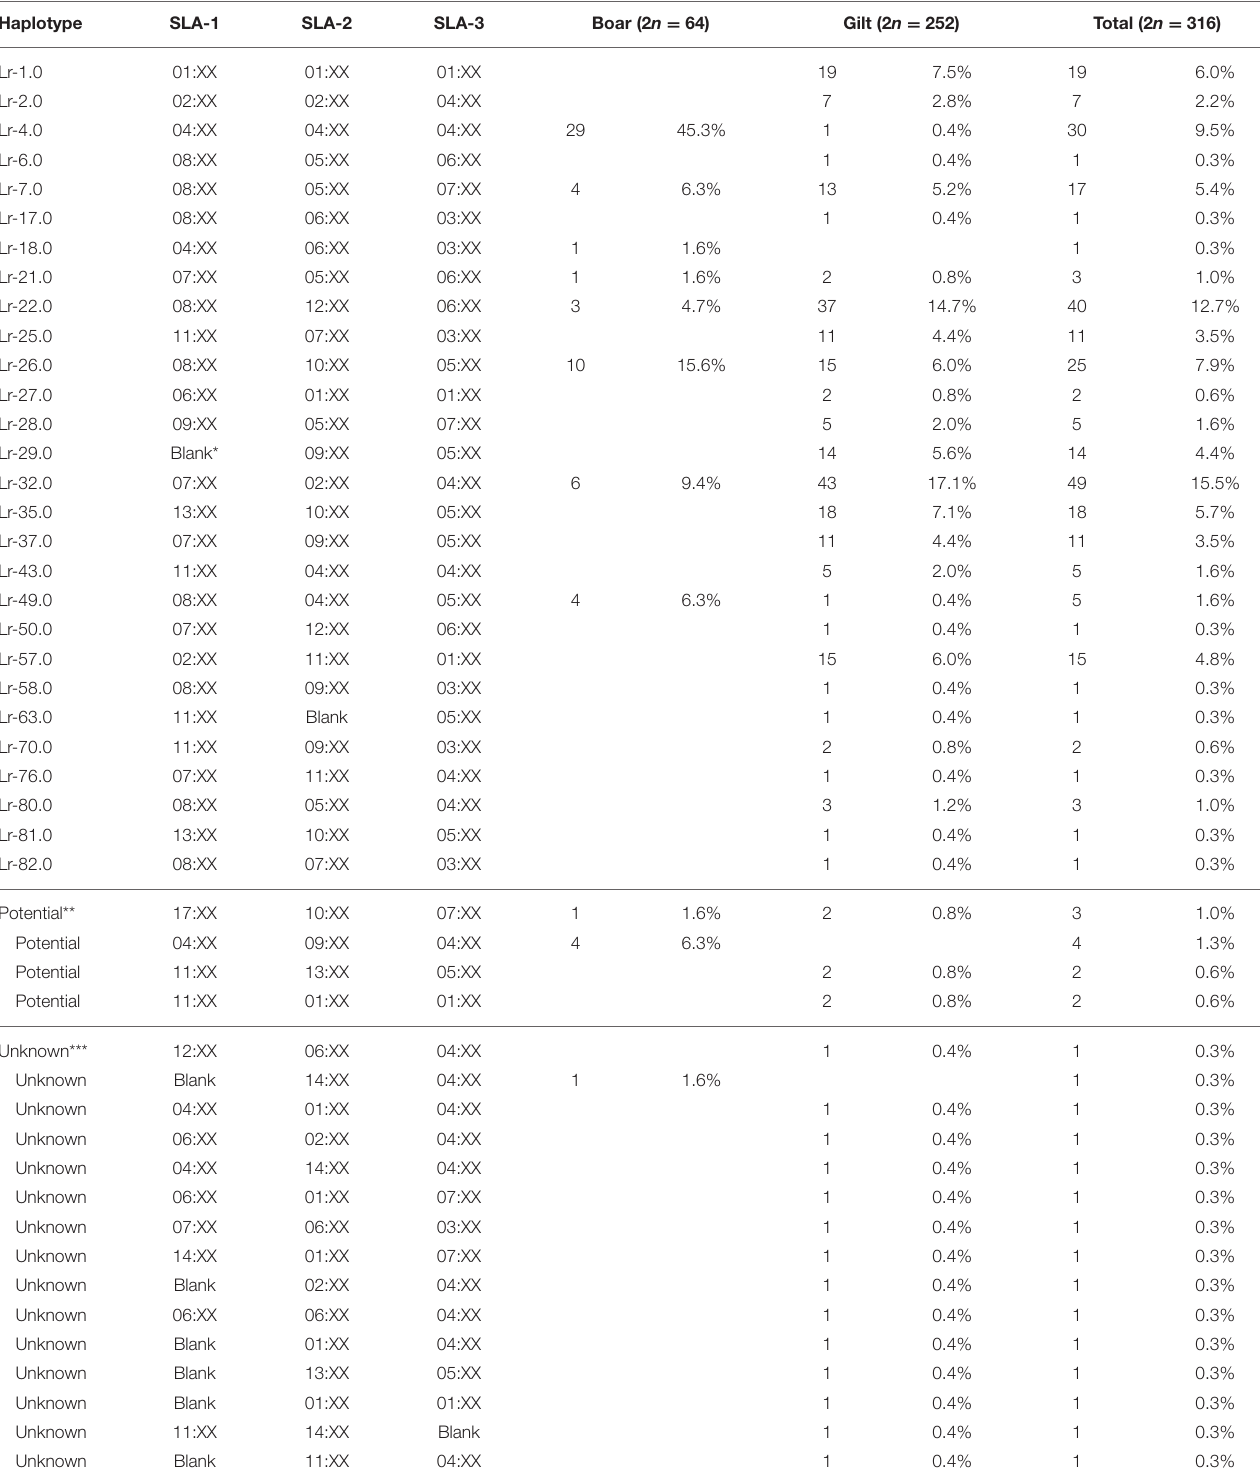
TABLE 2 | Frequency of SLA class I haplotypes.